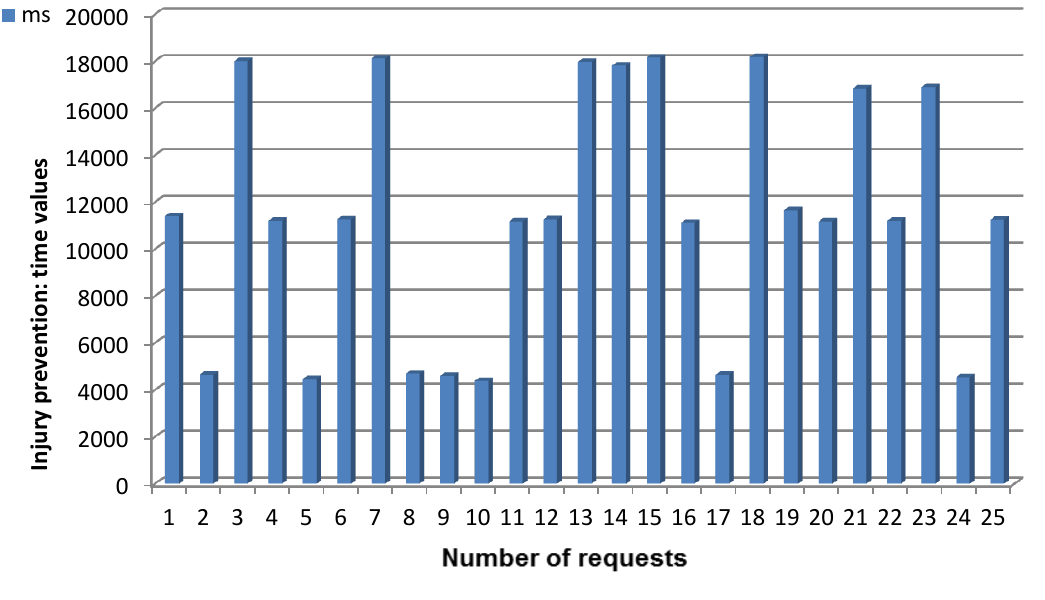
Figure 24. Time used in completing injury prevention service request (25 attempts).